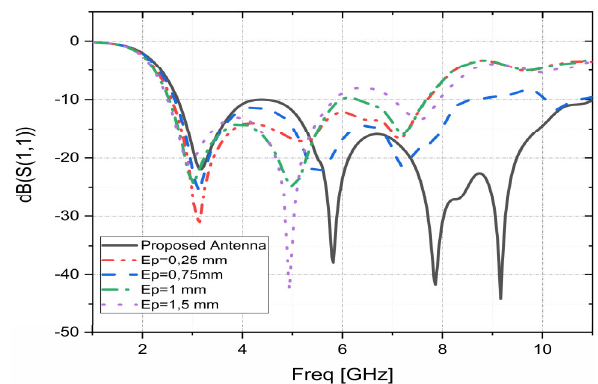
Figure 6. Simulated S11 parameters as functions of “Ep”.